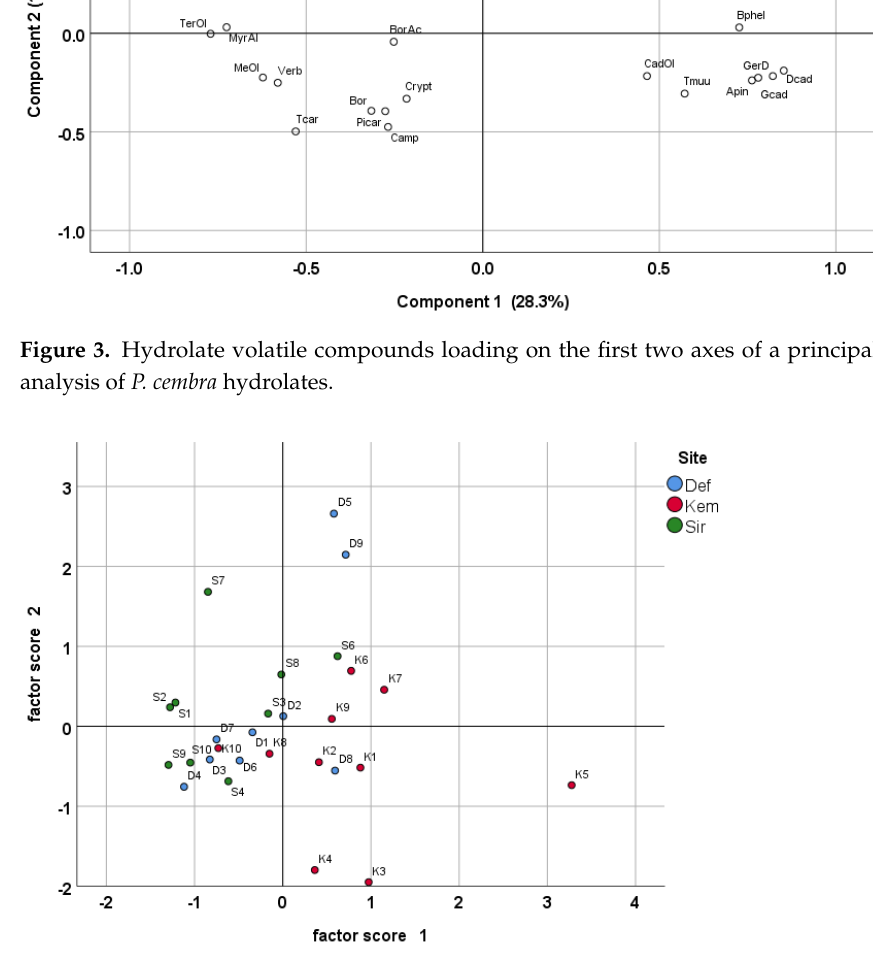
Figure 4. PCA scoring plot showing the hydrolate volatile samples from the individual P. cembra trees.